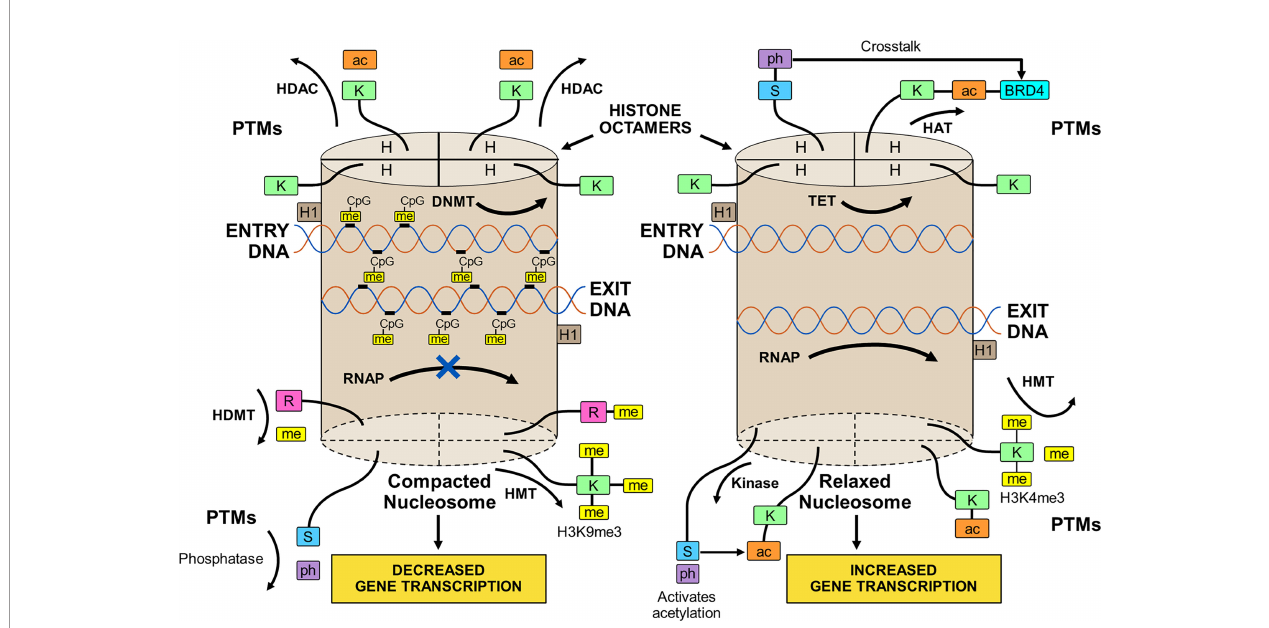
FIGURE 1 | Compacted and relaxed nucleosomes. Nucleosomes consist of two copies of four different histones (H) arranged as a histone octamer and double- stranded deoxyribonucleic acid (DNA) wrapped 1.65 times around each octamer. The entry and exit of the DNA from the nucleosome is secured by a linker histone (H1). Each core histone within the octamer has an N-terminal tail that can undergo post-translational modi fi cations (PTMs) by the attachment of methyl (me), acetyl (ac), or phosphate (ph) groups to a particular amino acid in the histone tail. Lysine (K), serine (S), or arginine (R) are among other amino acids that can serve as attachment sites. The PTMs are orchestrated by various enzymes. Methylation of the histone tail is catalyzed by histone methyltransferase (HMT); acetylation is catalyzed by histone acetyltransferase (HAT); and phosphorylation is catalyzed by kinases. The PTMs can be reversed by enzymes that dissociate the appended groups from the amino acid residues. Acetylation is reversed by histone deacetylase (HDAC); methylation is reversed by histone demethylase (HDMT); and phosphorylation is reversed by phosphatases. Histone acetylation relaxes the nucleosome and promotes gene transcription, and histone de-acetylation compacts the nucleosome (heterochromatin) and represses gene transcription. Histone methylation can decrease (H3K9me3) or increase (H3K4me3) transcription depending on the methylation site and other variables. Histone phosphorylation can recruit other molecules, such as bromo-domain-containing protein 4 (BRD4), to the acetylation site (crosstalk) and promote gene transcription. DNA can be methylated by DNA methyltransferase (DNMT) or de-methylated by ten-eleven translocation methylcytosine dioxygenase (TET). DNA methylation is restricted to sites in which cytosine (C) is separated from guanine (G) by a phosphate (p). Methylated DNA is compacted and transcription factors have limited access to transcription sites. Ribonucleic acid polymerase (RNAP) is prevented (X) from copying the nucleotide sequence, and gene transcription is decreased. De-methylated DNA is relaxed; RNAP can open the double-stranded DNA; and gene transcription is